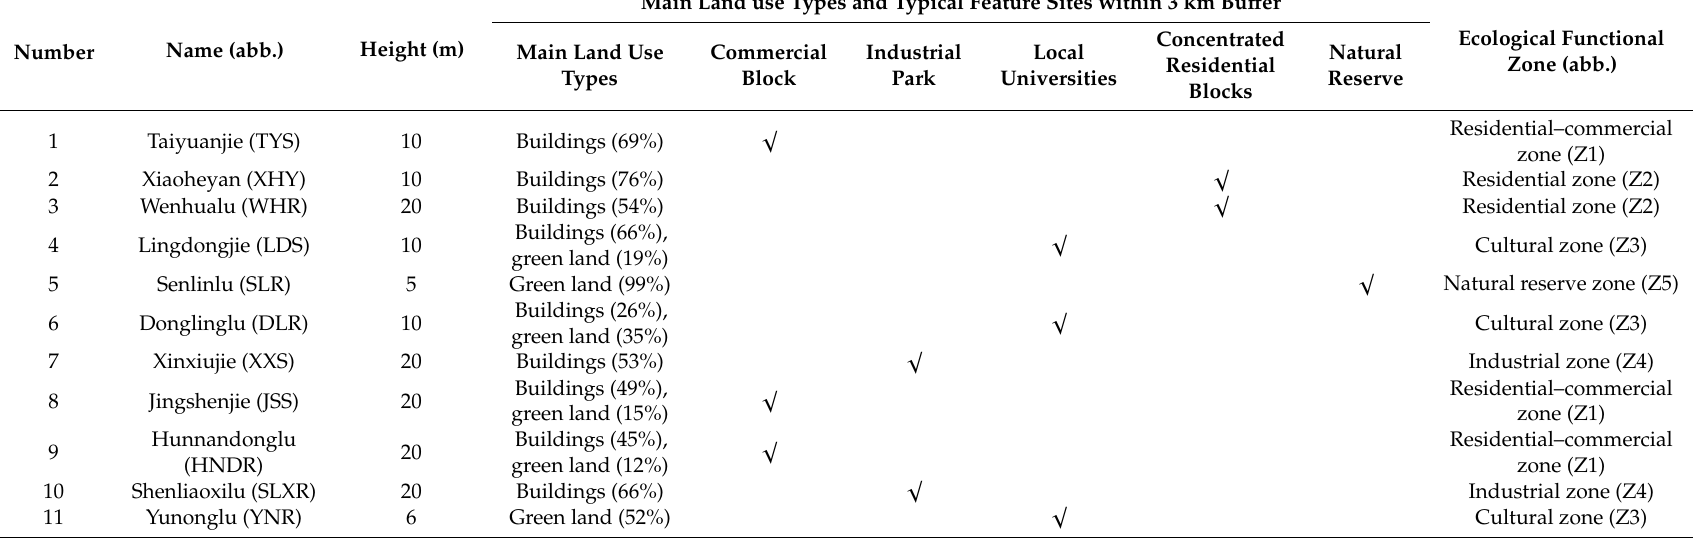
Table 1. Eleven air quality monitoring sites in Shenyang, Liaoning Province. Height refers to the height of the sampling port from the ground. The number in the brackets is the percentage of land use area within 3 km bu ff